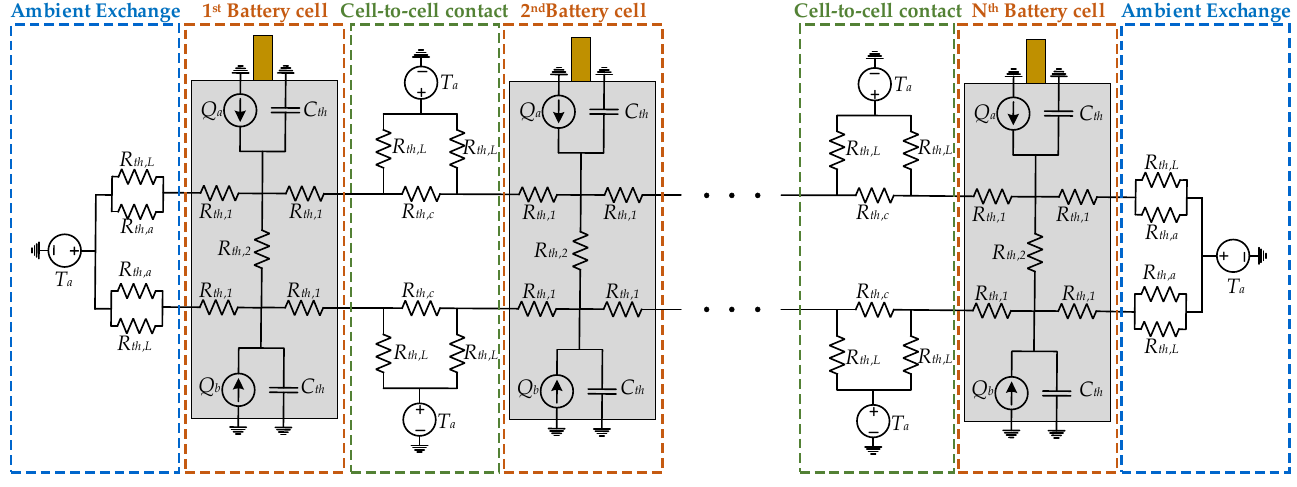
Figure 5. N-cell thermal model.